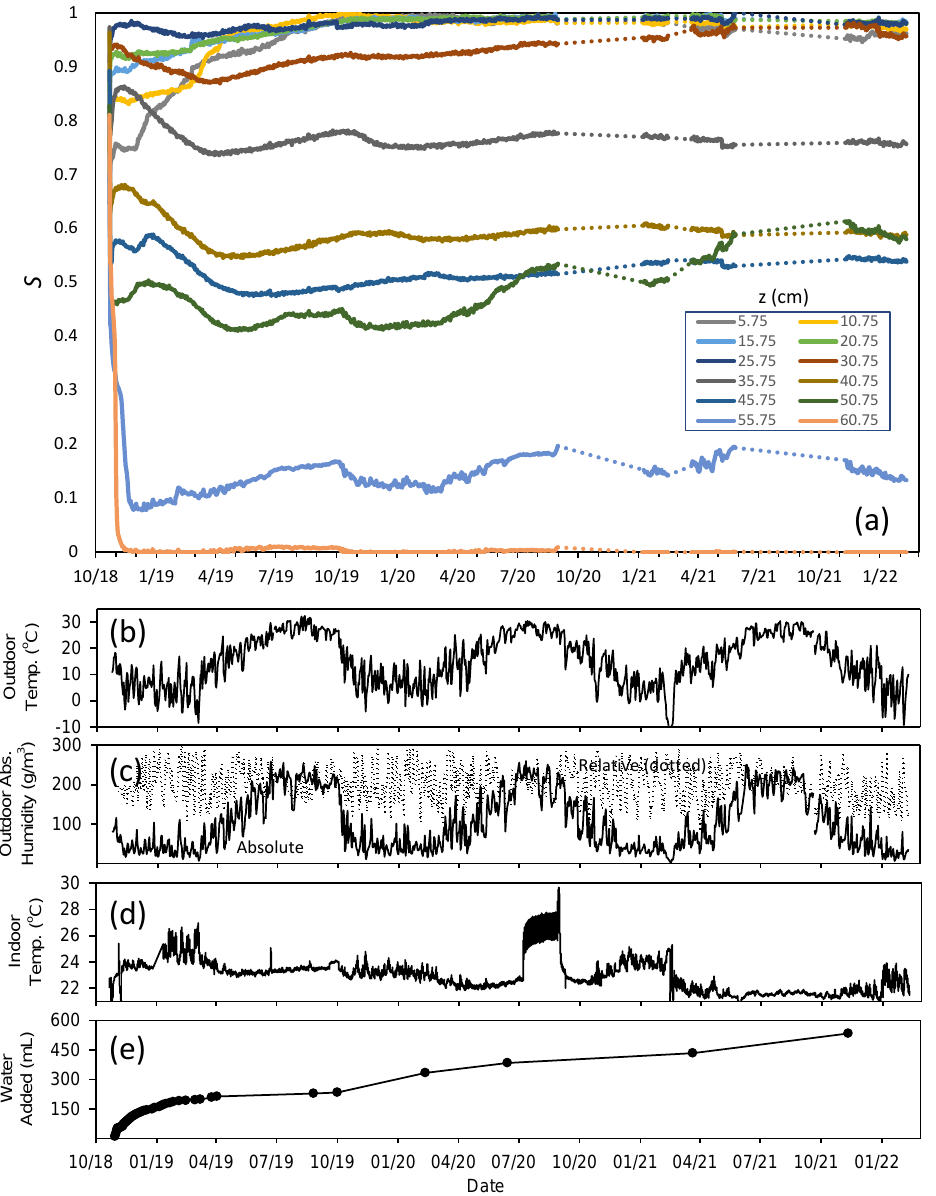
Figure 6. Saturation at the twelve sensors over the full 1207 days of the drainage experiment ( a ), and information on conditions over the duration of the experiment: ( b ) Outdoor temperature; ( c ) Outdoor absolute and relative humidity (note: relative humidity scale is not shown, but varies from 0 to 100% over vertical axis); ( d ) Indoor temperature; ( e ) Cumulative water added. Periods where sensor data collection experienced interruptions are indicated with dotted lines. Sensor elevation (z) in ( a ) is reported from the water